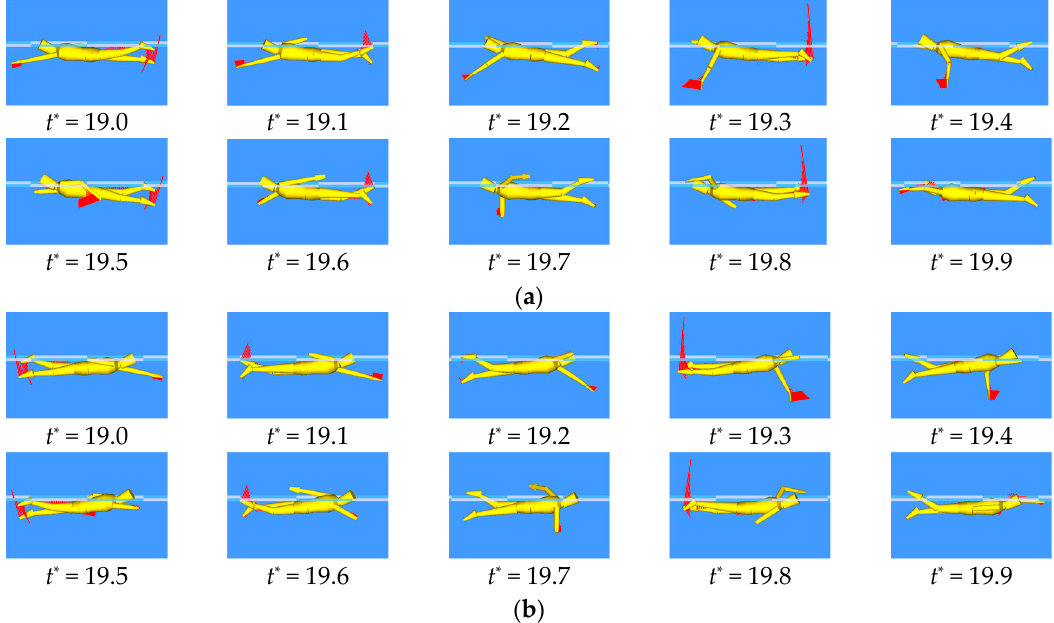
Figure 2. Simulated swimming motion for the last stroke cycle. ( a ) Left side (intact limb side) view; ( b ) Right side (deficient limb side) view. The red lines from the swimmer’s body represent the point of application, direction and magnitude of the fluid forces acting on the swimmer. The symbol t * is the nondimensional time normalized by the stroke cycle.